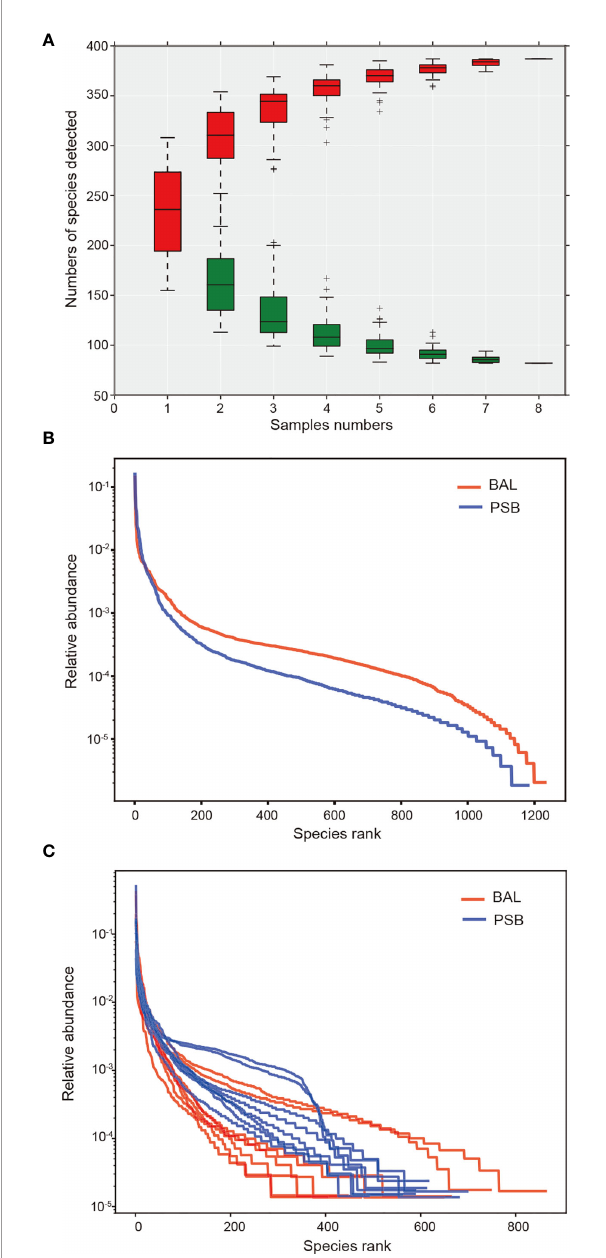
FIGURE 2 | Changes in microbiome diversity in microbial acquisition modalities. In this fi gure, we measured the relationship between the number of samples and the number of species annotated using a species relative abundance accumulation curve. (A) The relative abundance accumulation curve of species shows that the eight samples were suf fi cient for further research. The abscissa represents the grouping; the vertical axis represents the distance; boxes of different colors represent each grouping, with red representing PSB and green representing BAL. Rank abundance curves and diversity indexes between BAL (n = 8) and PSB (n = 8) groups (B, C) , con fi rming signi fi cant differences in species diversity between groups. Species abundance is re fl ected by the length of the curve on the horizontal axis, and the uniformity of species composition is re fl ected by the shape of the